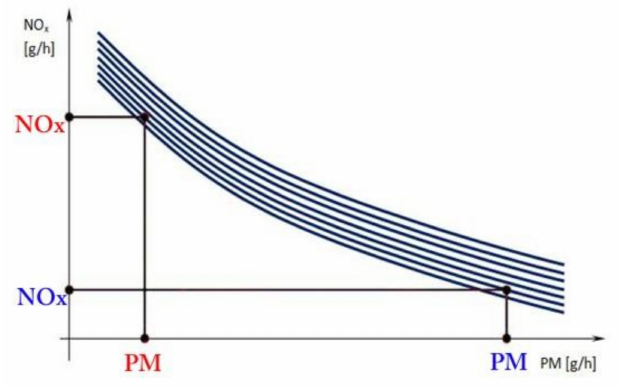
Figure 13. A schema of the NO x -PM emission trade-off.